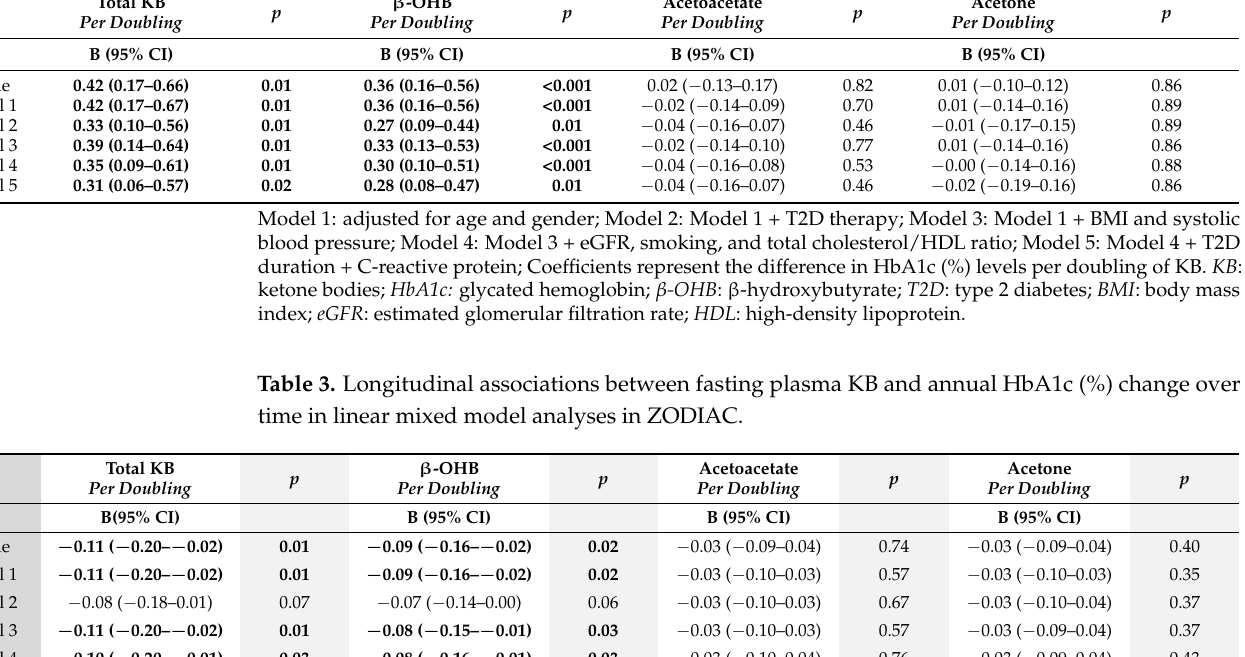
Model 1: adjusted for age and gender and baseline HbA1c; Model 2: Model 1 + T2D therapy; Model 3: Model 1 + BMI and systolic blood pressure; Model 4: Model 3 + eGFR, smoking, and total cholesterol/HDL ratio; Model 5: Model 4 + T2D duration + C-reactive protein. Linear mixed model analyses were performed on all individuals with ≥ 2 HbA1c measurements. A p -value of <0.05 was considered statistically significant. All models were adjusted for time as the main fixed factor in linear mixed model analyses. The estimates and p -values for the interactions of KB with time are depicted. Coefficients represent the yearly change in HbA1c (%) levels per doubling of KB. KB: ketone bodies; HbA1c: glycated hemoglobin; β -OHB : β -hydroxybutyrate; T2D : type 2 diabetes; BMI : body mass index; eGFR : estimated glomerular filtration rate; HDL : high-density